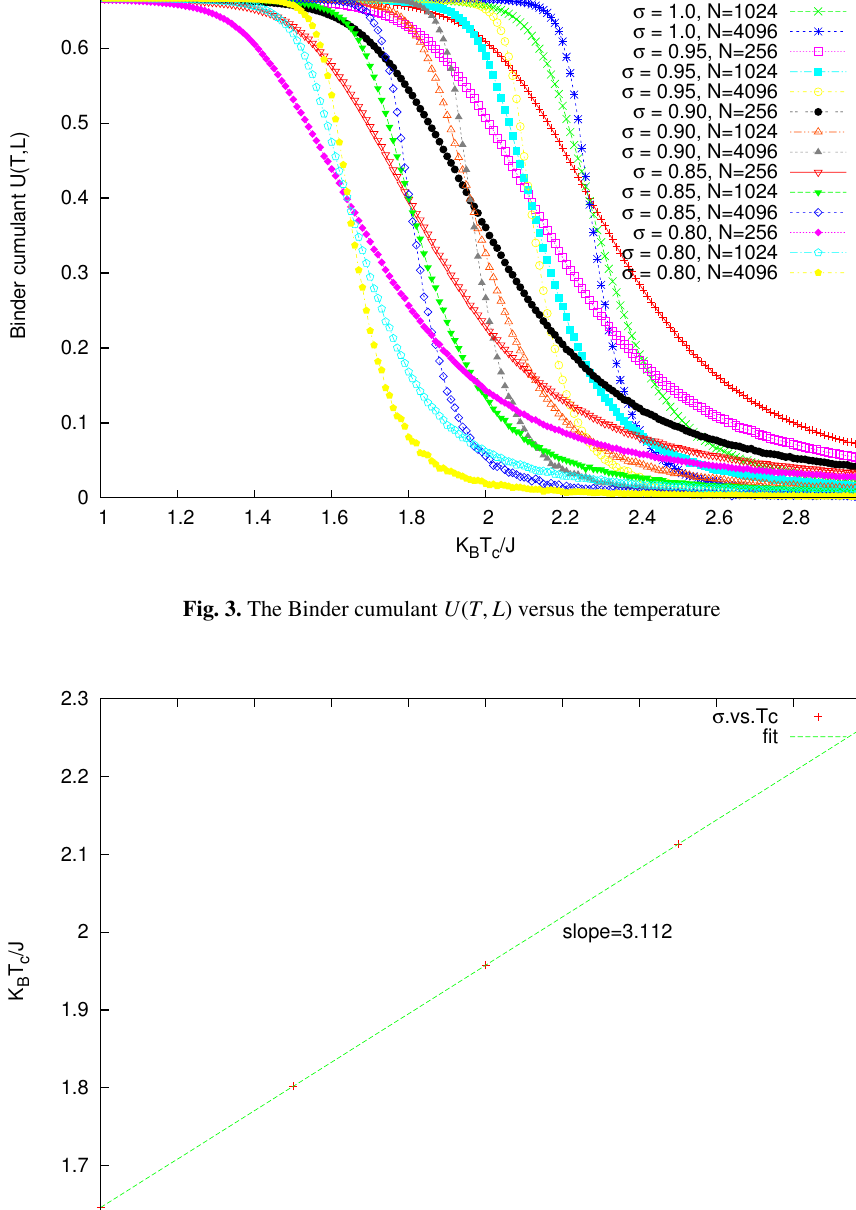
The slope of the T c ( σ ) line is found to be 3 . 112 ± 0 . 023 relative to that determinated by Harris [13] which is 3 . 016 and for Jayaprakash [12] is 3 . 108. This value of the slope is calculated near